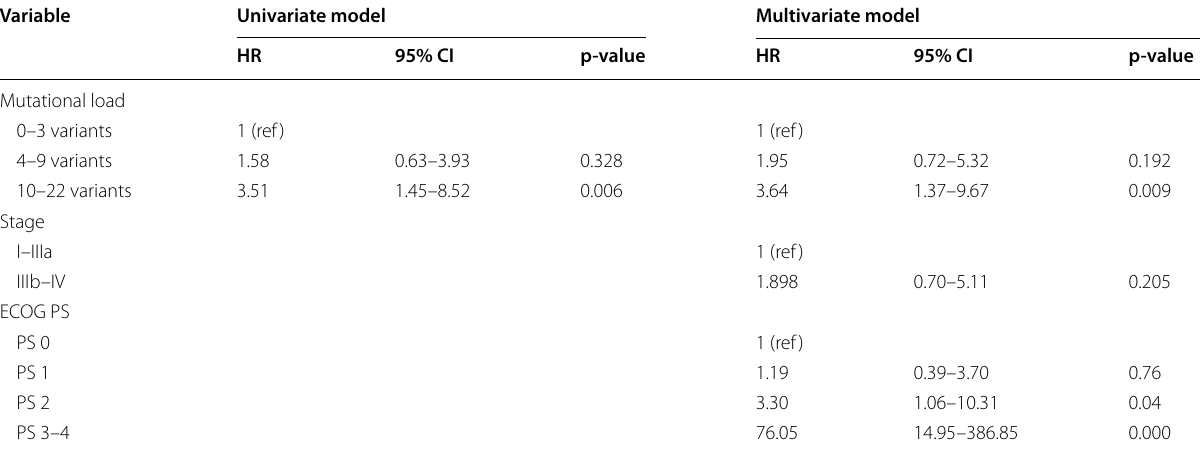
ECOG PS Eastern cooperative oncology group performance status, HR hazard ratio, CI confidence interval